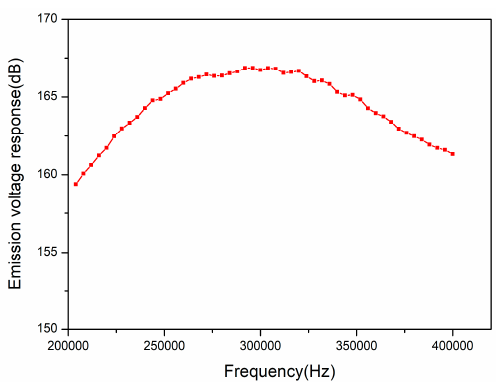
Figure 9. The transmitting voltage response curve obtained from the model simulation.